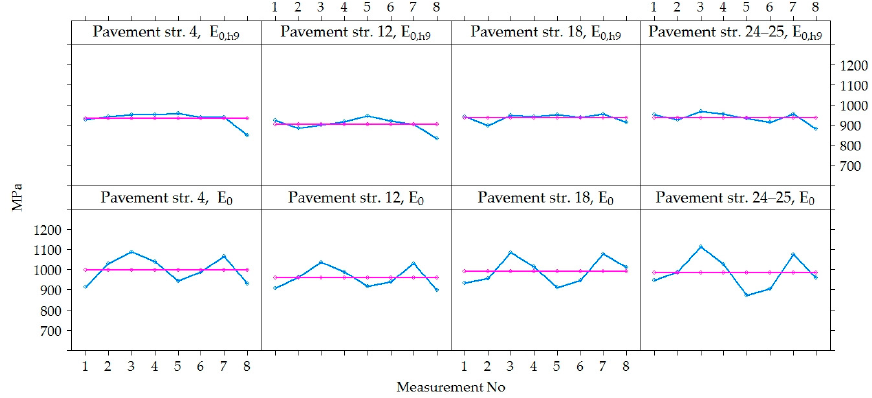
Figure 15. E 0 and E 0,h9 mean values and their fluctuations regarding the total average in each section.